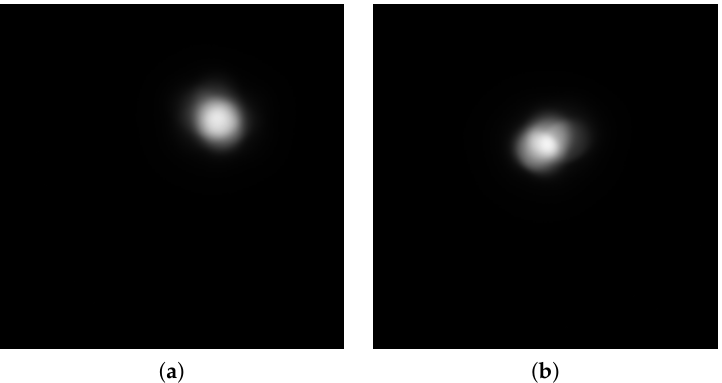
Figure 5. Base images for the energetic characterization of the Fresnel lens. ( a ) Focal length 3.74 m, ( b ) Focal length of 3.56